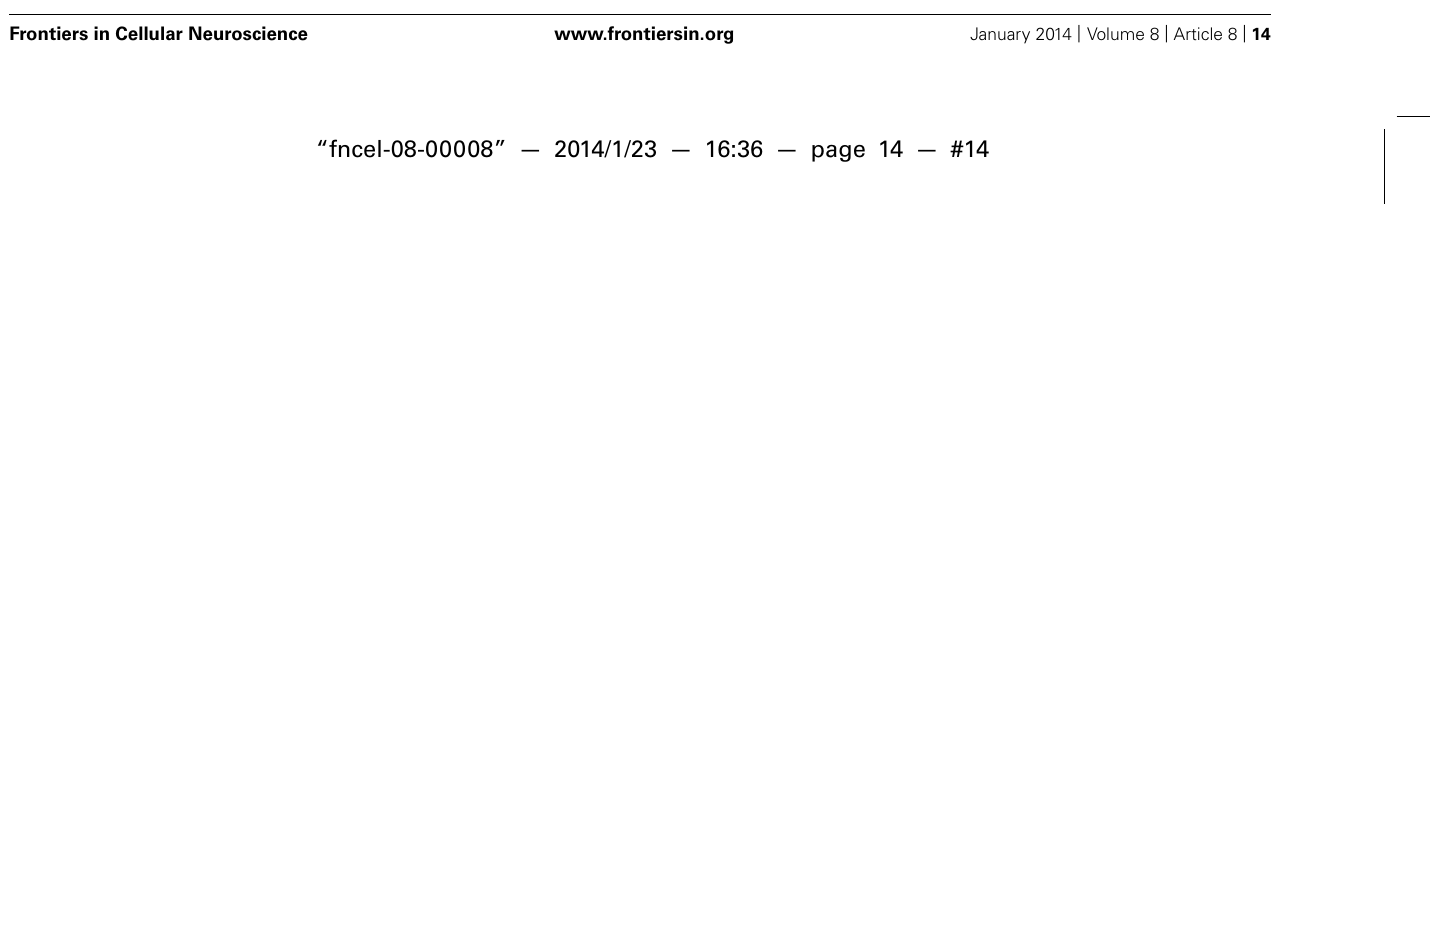
In SOM-ires-Cre drivers, major dendrite-targeting interneu- ron subclasses are captured in the cortex and